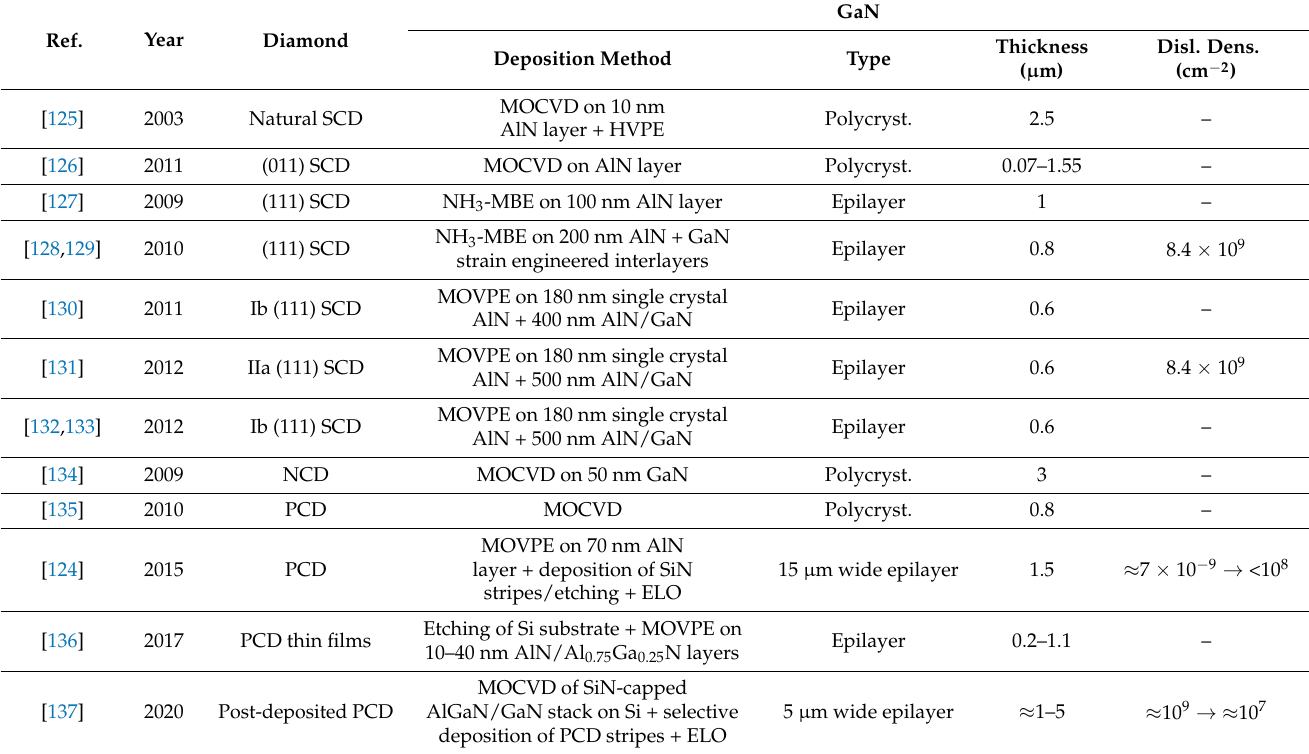
Table 5. GaN epitaxy on diamond